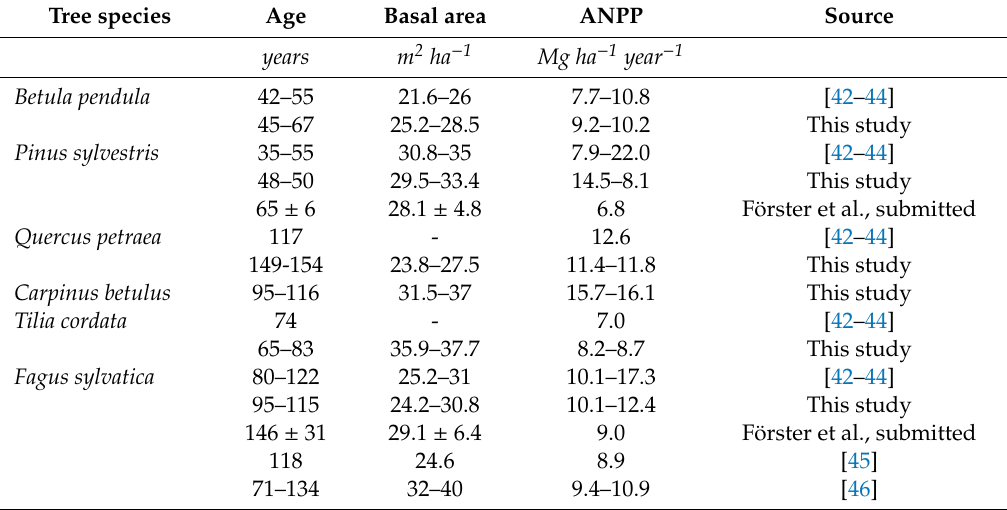
Table 4. Aboveground net primary productivity in stands dominated by the six tree species of this study according to own results and literature data